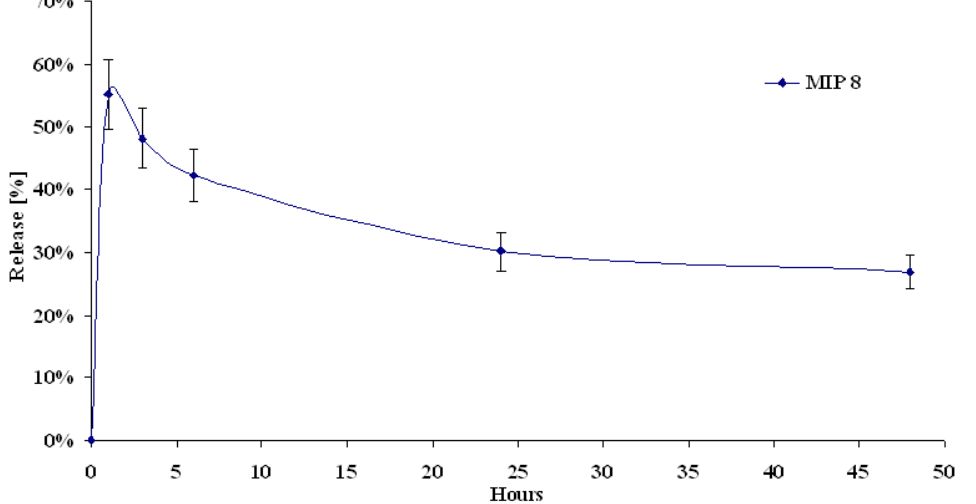
Figure 10 . Release profile of molsidomine from MIP8 at total volume exchange of releasing